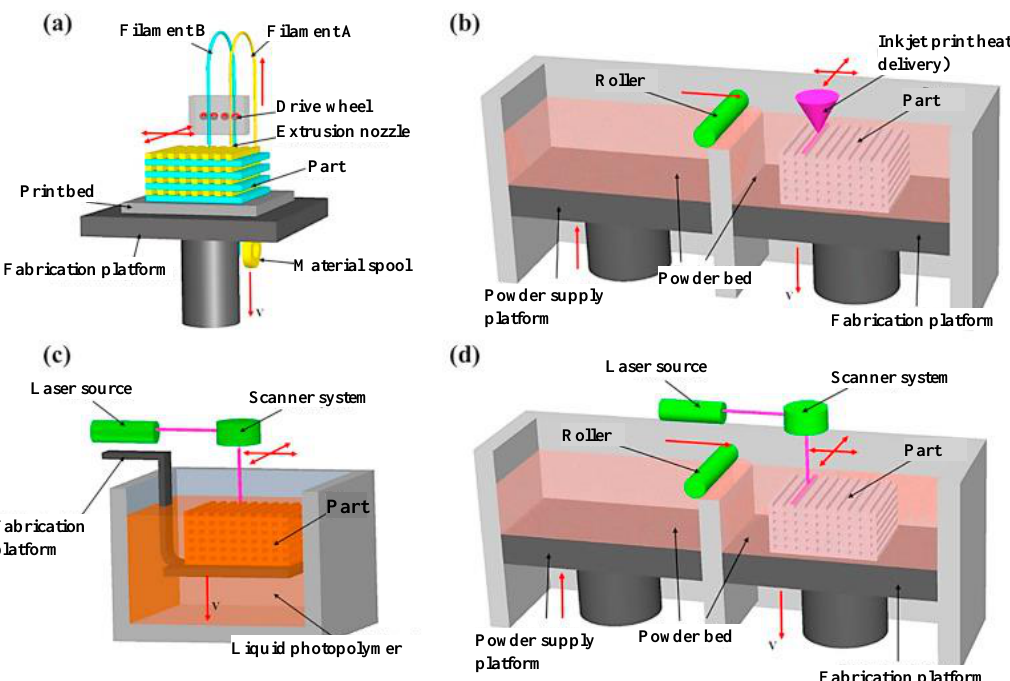
Figure 1. Schematic representation of some of the main additive manufacturing (AM) methods: ( a ) fused deposition modelling; ( b ) inkjet printing; ( c ) stereolithography; ( d ) powder bed fusion. Adapted from [6] with permission from Elsevier.